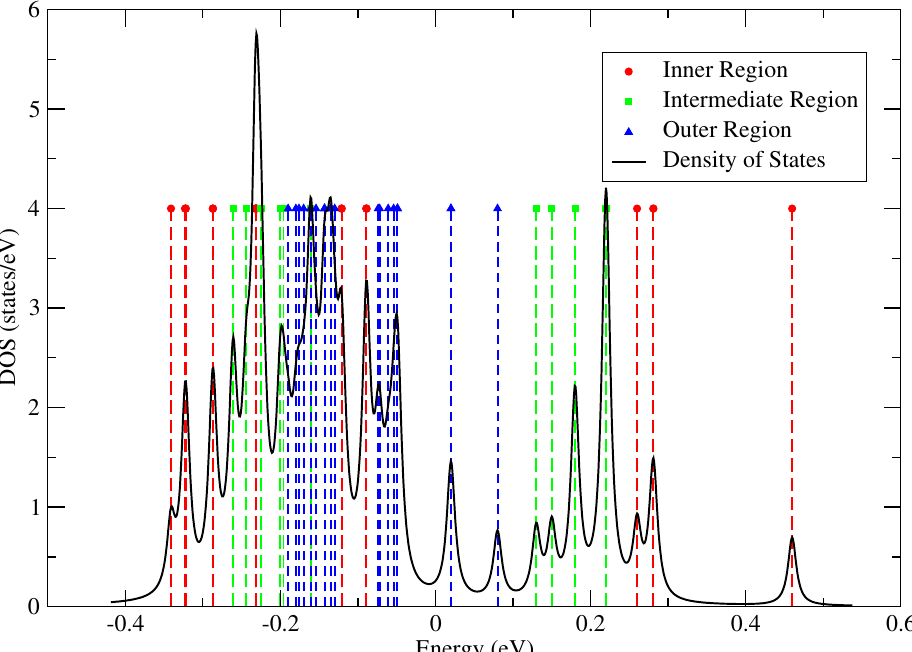
Figure 4. Each vertical line corresponds to one data point (due to symmetry, some points overlap). The colors correspond to the distances from the dislocation core, measured by the radius R. The red circles correspond to the 24 points closest to the dislocation core (R < 2.87 Å), the green squares are in the “intermediate range” (2.87 Å < R < 4.04 Å), with the blue points belong are the outermost 24 points. The density of states (DOS) curve is generated by broadening the delta functions by a Lorentzian function of width k B T/2 (T = 300 K), with the integral under the DOS curve being normalised to